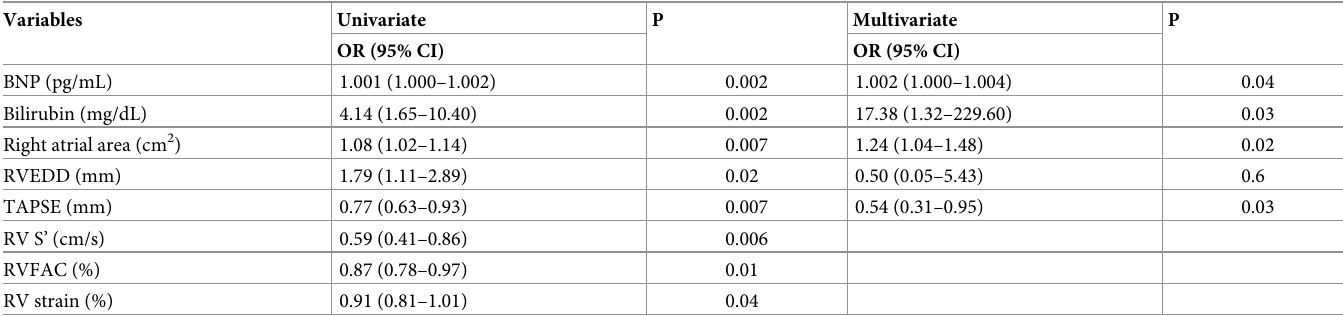
Table 4. Predictors of mortality in the study